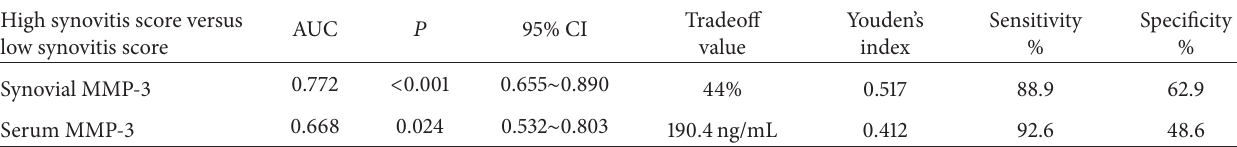
Table 2: Areas under the curve (AUC) of synovial and serum MMP-3 as biomarkers for distinguishing high grade synovitis. High synovitis score versus